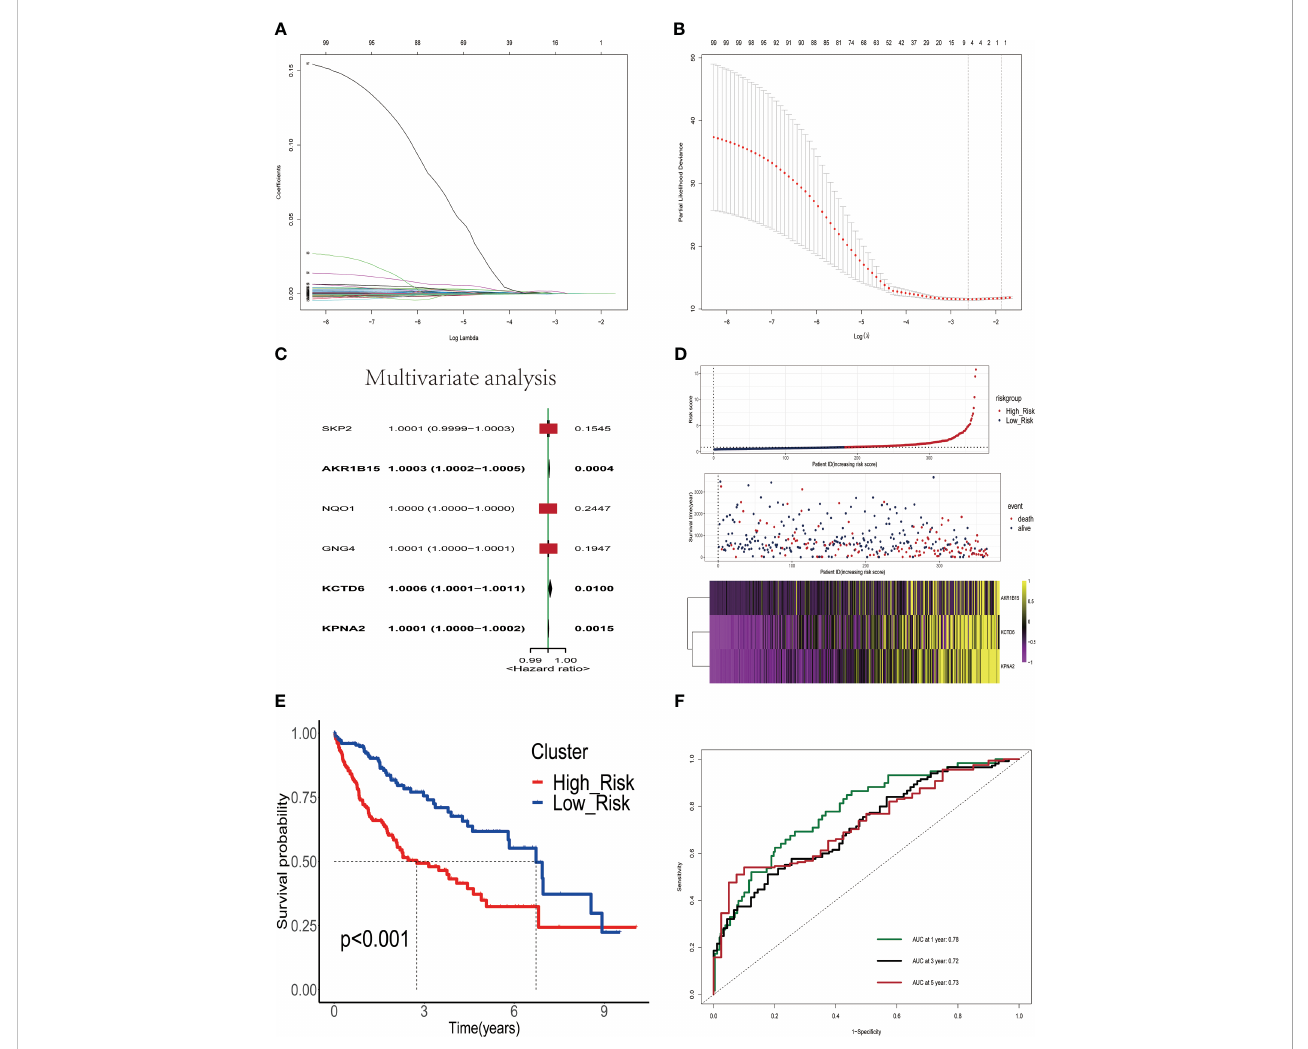
FIGURE 2 Construction and validation of a prognostic signature based on estrogen-related genes. (A) The coef fi cients of genes calculated by multivariate Cox regression using LASSO. (B) The partial likelihood deviance of genes. (C) Results of multivariate analysis of six differentially expressed estrogen-related genes. (D) The association of risk scores with survival status and gene expression in HCC patients. (E) Kaplan-Meier curves were used to compare the overall survival of HCC patients between the high-risk and low-risk groups. (F) ROC curves of the prognostic signature for predicting the risk of death at 1, 3, and 5